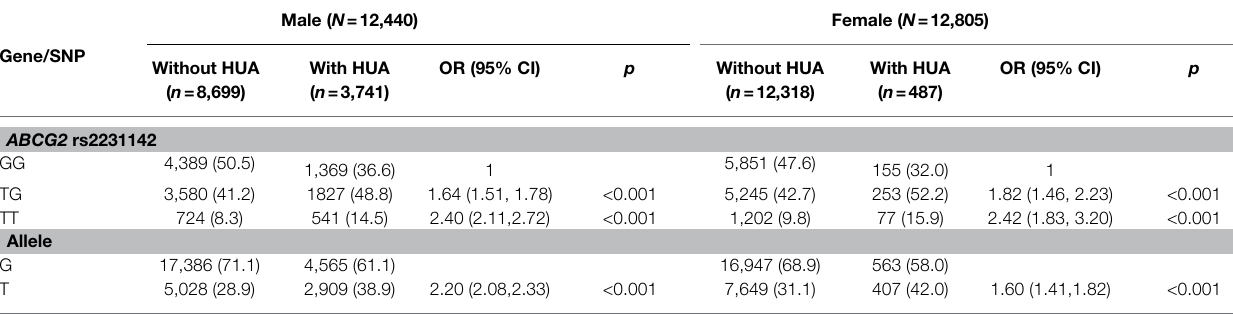
TABLE 2 | Genotype and allele frequencies of ABCG2 rs2231142 and risk of hyperuricemia in the participants.